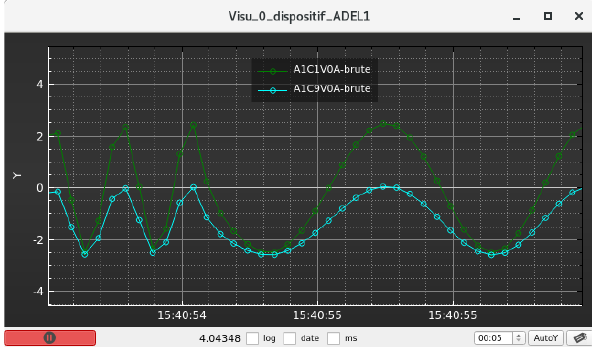
Fig. 6. Online data visualization.